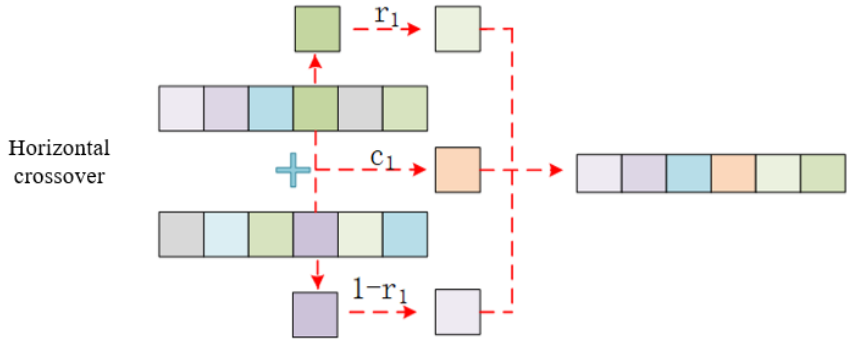
Figure 1. Schematic of horizontal crossover.